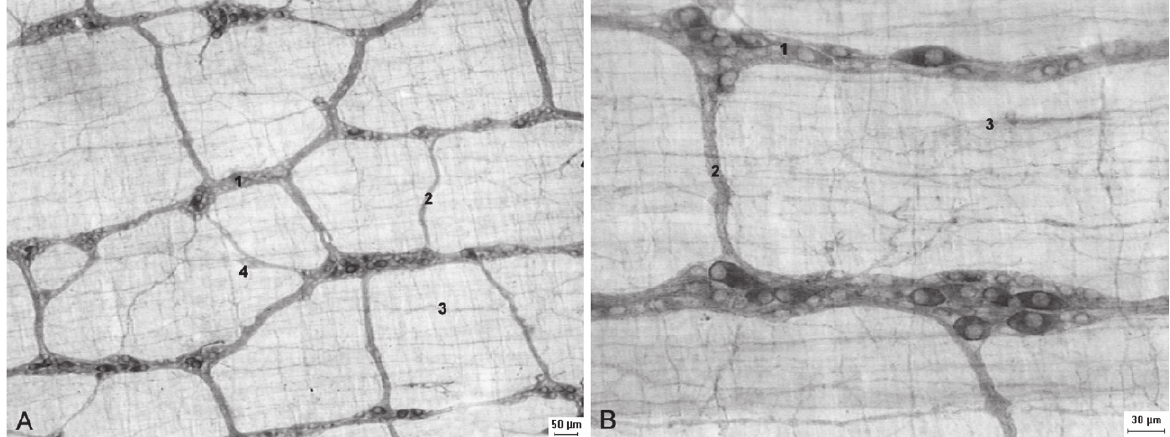
Figure 1 - Micrographs showing the components of the myenteric plexus of the ileum of rats stained by the myosin-V technique. Figure A e B: 1 – primary plexus; 2 – secondary plexus; 3 – tertiary plexus; 4 – isolated neurons. Calibration bar: (A) 50 µ m and (B) 30 µ